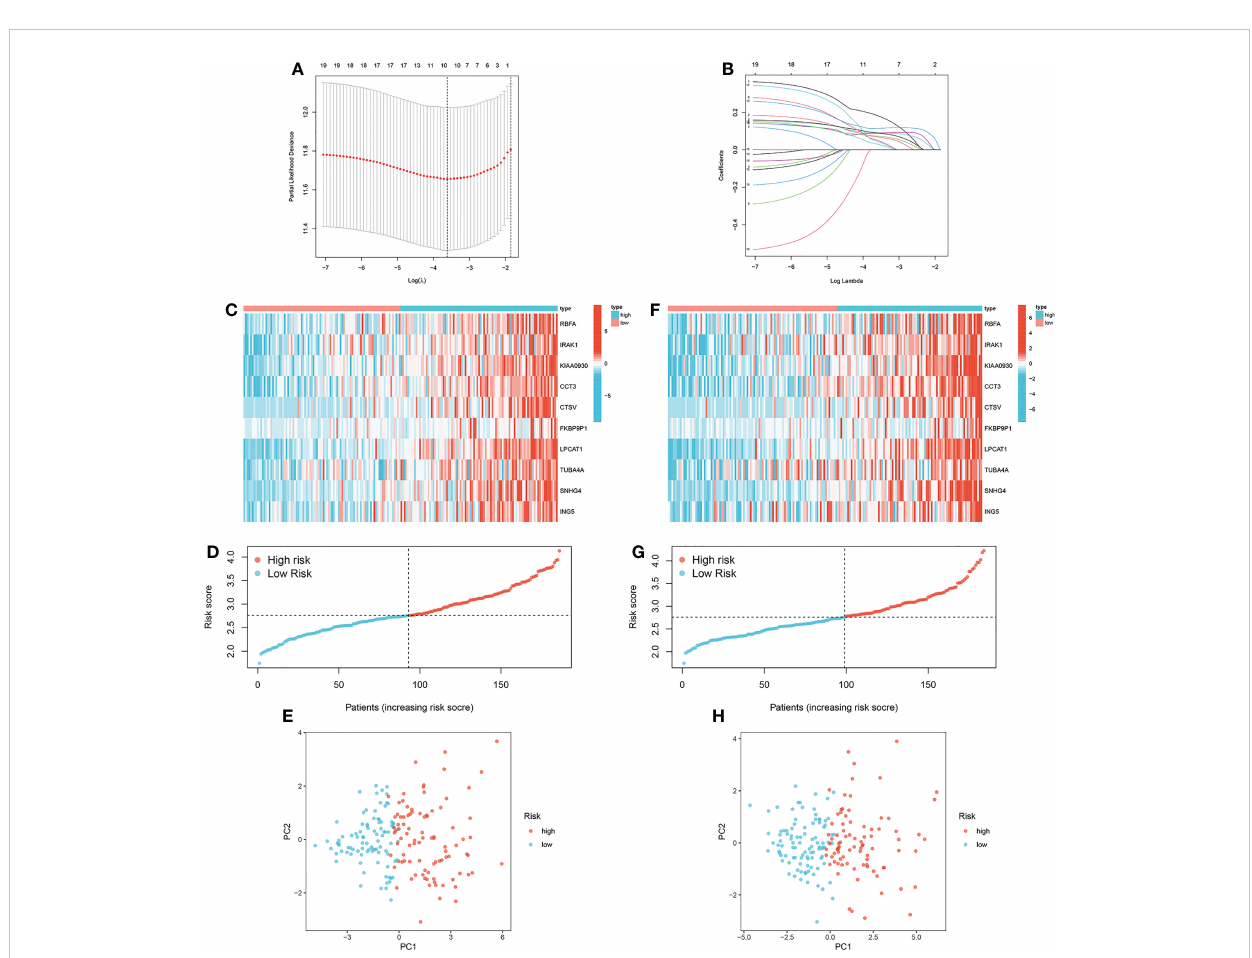
FIGURE 5 Construction of the prognostic signature based on MRGs. (A, B) LASSO regression analysis in the training cohort. (C) Expression pattern of the ten MRGs between the low-risk group and the high-risk group in the training cohort. (D) Distribution of patients with risk scores in different risk groups in the training cohort. (E) Principal component analysis in the training cohort. (F) Expression pattern of the ten MRGs between the low-risk group and the high-risk group in the internal validation cohort. (G) Distribution of patients with risk scores in different risk groups in the internal validation cohort. (H) Principal component analysis in the internal validation